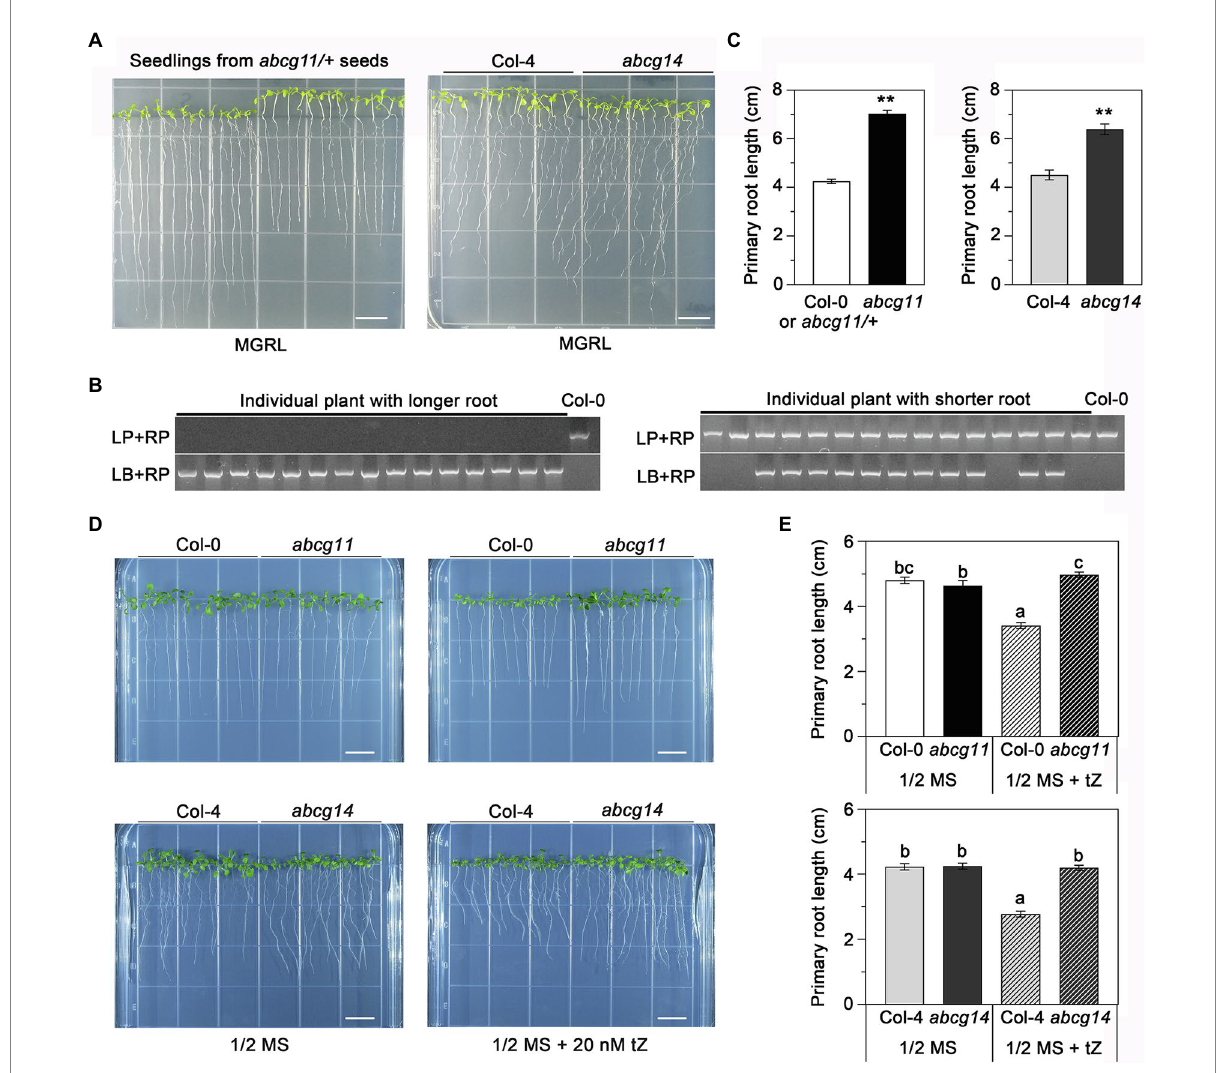
FIGURE 4 abcg11 behaves similarly as abcg14 in root growth on MGRL medium and in response to exogenous cytokinins. ( A , left panel) The progeny of abcg11/+ plants exhibit two distinct phenotypes. The seeds were sown on MGRL medium and grown vertically for 12 days under short-day conditions (8 h light/16 h dark). Note that seedlings were rearranged according to their primary root length before taking the picture. ( A , right panel) Phenotype of abcg14 under the same conditions. Scale bars, 1 cm. (B) Genotyping of the individual seedlings shown in (A), left panel. Note how the seedlings with longer roots are abcg11 homozygous mutants. The primers for genotyping are listed in Supplementary Table S2. (C) Primary root length of seedlings in (A) . Data are shown as means ± SE ( n = 15). Asterisks represent significant differences by Student’s t -test: ** p < 0.01. (D) Phenotype of seedlings grown with or without 20 nM trans -zeatin (tZ) for 12 days under long-day conditions (16 h light/8 h dark) on half- strength MS medium. The photographs are representative of three independent experiments. Scale bars, 1 cm. (E) Primary root length of the seedlings in (D) . Data are shown as means ± SE ( n = 40). Different letters indicate significant differences, as determined by one-way ANOVA ( p <